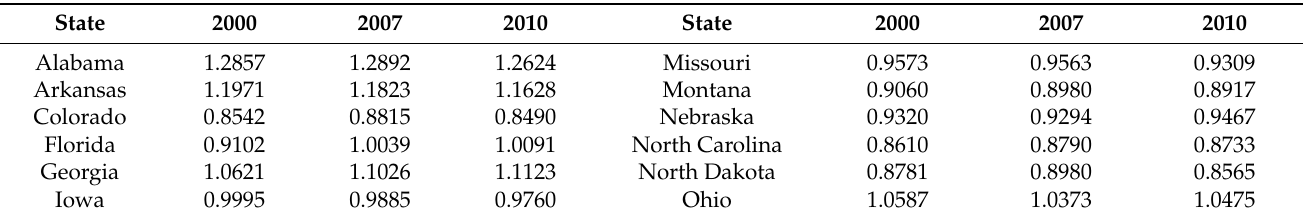
Table 6. Power law exponents of the regressions between the population numbers and total en- trepreneurship of groups of counties in 29 U.S.